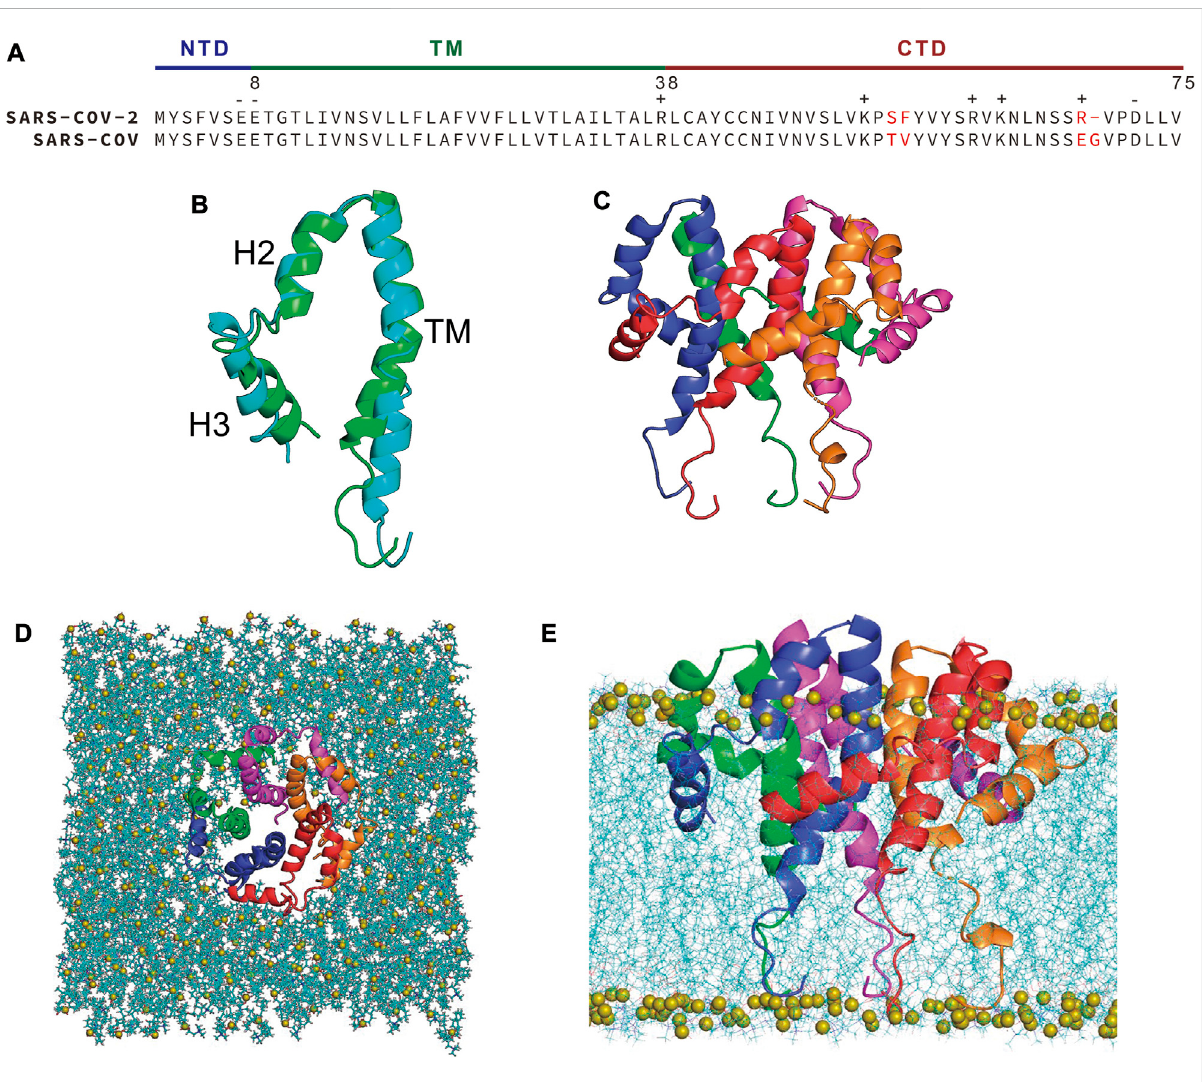
FIGURE 1 (A) Sequence alignment of SARS-CoV-2 and SARS-CoV E protein. Non-conserved residues are highlighted in red. (B) Superposition of the homology model of SARS-CoV-2 E protein (green) and the NMR structure (PDB code: 5X29) of SARS-CoV E protein (cyan). (C) Assembled pentamericmodelofSARS-CoV-2Eprotein. (D) Topviewand (E) sideviewoftheSARS-CoV-2EproteinembeddedinaPOPCbilayer.ChainA-Eare coloredwithred,blue,green,magentaandorange,respectively.Lipidsareshownasbluelines,withthephosphorusatomsofthelipidshownas olive